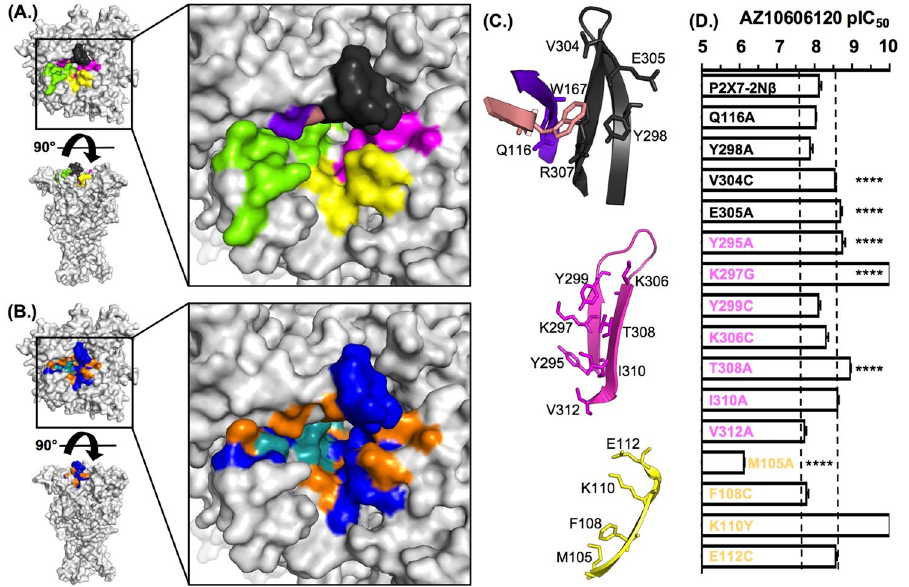
Figure 5. Contribution of variations around the putative allosteric binding pocket to AZ10606120 sensitivity. ( A ) The putative allosteric binding pocket is lined by residues from regions 81–94 (green), the loop 295–310 (magenta), strand 105–112 (yellow) and a series of other residues on the adjacent subunit (Q116 brown, W167 purple and residues on the other side of the loop 295–310 shown in black). ( B ) Individual point mutants with ≤ 3 fold change in AZ10606120 sensitivity are shown in orange, mutants that increased sensitivity are shown in blue and decrease AZ10606120 action in teal. ( C ) Cartoons showing the location of residues around the allosteric pocket. ( D ) Summary of pIC 50 values of AZ10606120 at mutant P2X7 receptors. A three-fold change from P2X7-2N β is indicated by the dotted line. Significance levels are shown on the graph only for those with > 3 fold change in sensitivity. n = 3–7, **** p <